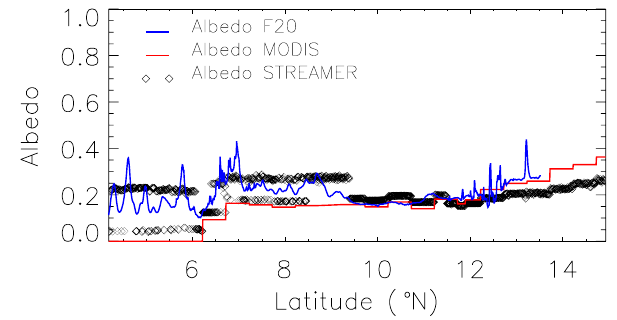
Fig.3. SurfaceshortwavealbedofromMODIS(redline)derivedalongtheF/F20flighttrackon14June2006. Superimposedarethetotal Fig. 3. Surface shortwave albedo from MODIS (red line) derived effectivealbedo(accountingforthesurface,aerosolandclouds)obtainedfromshortwavedownwellingandupwellingairborneirradiances (blueline)andfromSTREAMER-simulatedirradiances(darkdiamonds). along the F/F20 flight track on 14 June 2006. Superimposed are the total effective albedo (accounting for the surface, aerosol and clouds) obtained from shortwave downwelling and upwelling air- borne irradiances (blue line) and from STREAMER-simulated irra- diances (dark